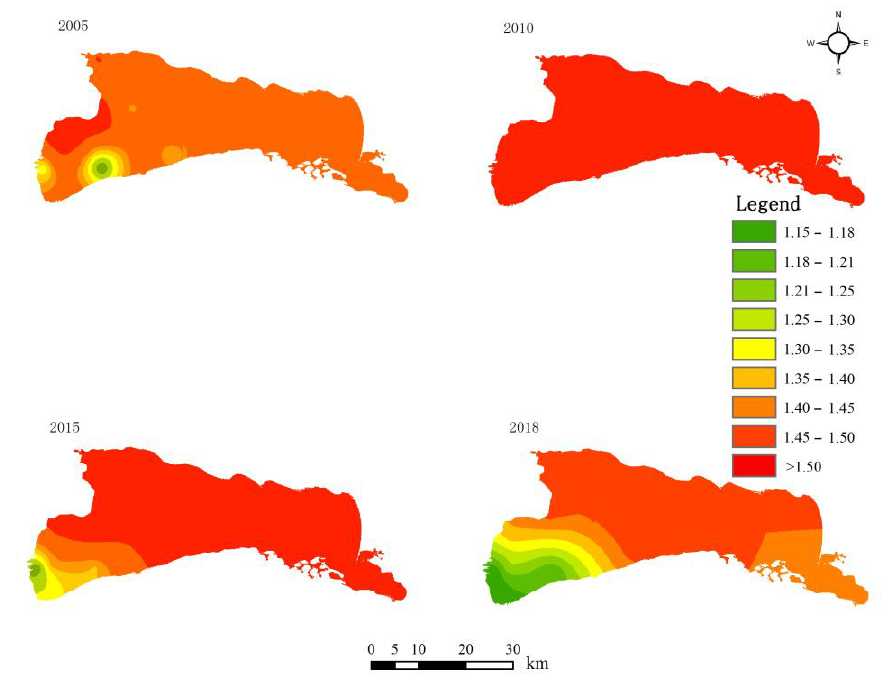
Figure 7. Spatial distribution of TDS content of Bosten Lake water in 2005, 2010, 2015, and 2018.